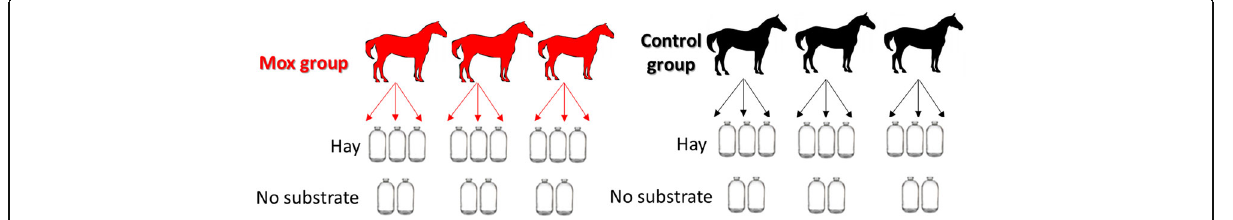
Fig. 6 Experimental design of fermentation experiment, repeated at each sampling time